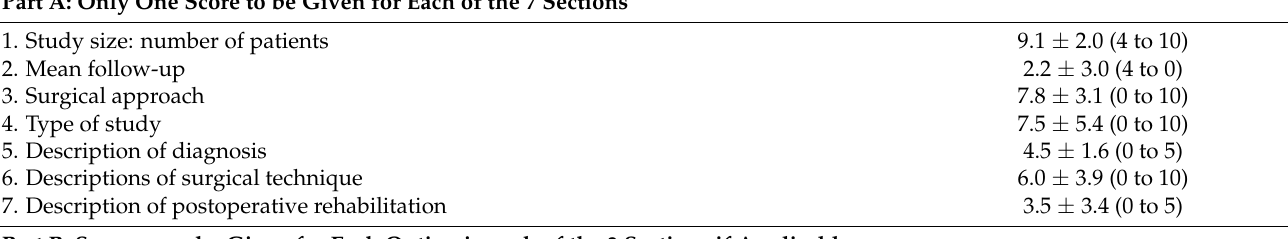
Table 1. Coleman methodology